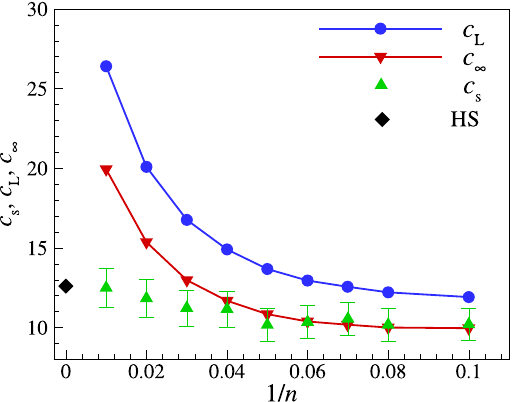
Figure 3. Sound velocity of IPL melts versus the inverse IPL exponent 1/ n (softness parameter). The green data (up triangles) correspond to the (adiabatic) sound velocities obtained directly from MD simulations ( c blue data (circles) are the sound velocities obtained using QCA model ( c show the instantaneous sound velocities ∞ c . The black diamond at = ∞ n corresponds to the adiabatic sound velocity of the hard sphere fluid at the fluid-solid coexistence. All velocities are expressed in units of the thermal velocity v T